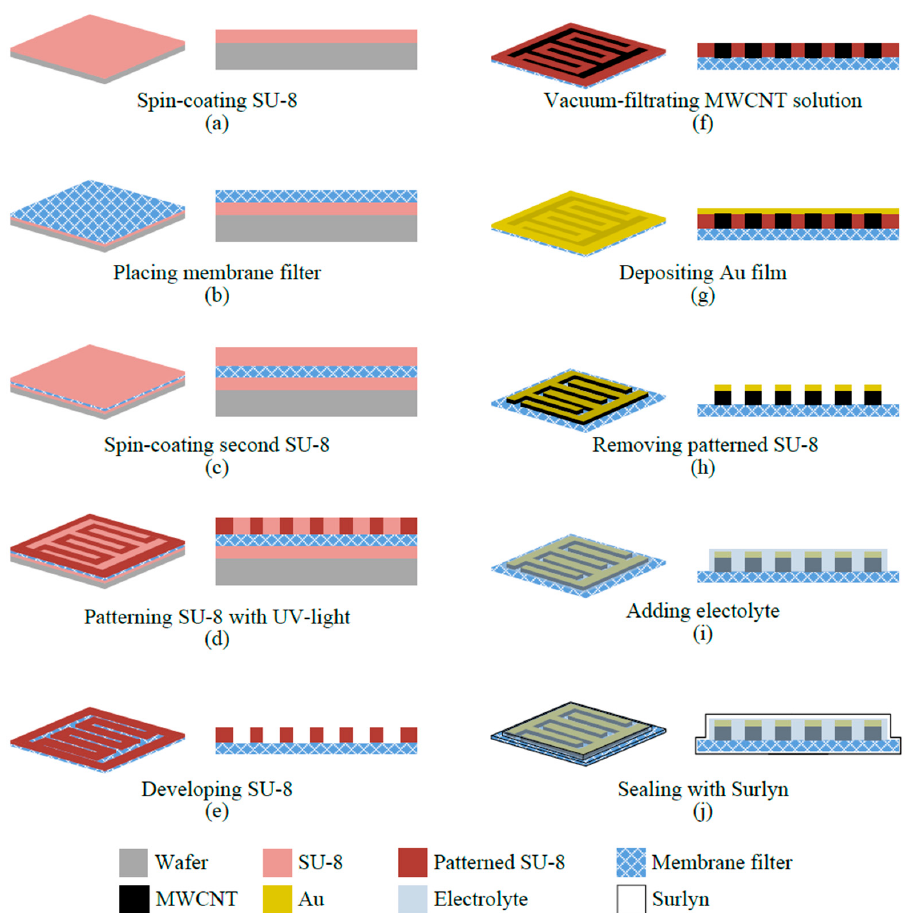
Figure 2. The fabrication process of the supercapacitor with interdigital patterned buckypaper electrodes: ( a ) spin-coating first SU-8 layer; ( b ) placing nylon membrane filter on the top of first SU-8 layer; ( c ) spin-coating second SU-8 layer on nylon membrane filter; ( d ) patterning SU-8 using a standard photolithography process; ( e ) developing SU-8; ( f ) vacuum filtrating MWCNT solution with SU-8 patterned nylon membrane filter; ( g ) depositing Au film on the surface of buckypaper; ( h ) removing SU-8 frame; ( i ) adding electrolyte to electrodes; ( j ) sealing device with polymer films. The measured relationships between the thickness of the fabricated buckypaper and the